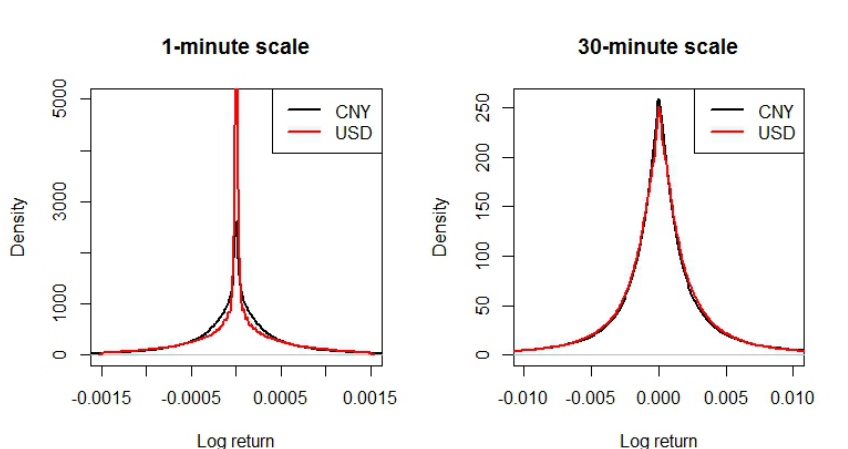
Figure 5. Distribution of high-frequency returns computed from closing prices on a minute scale and a half-an-hour scale for Bitcoin prices in CNY (black) and USD (red). A non-Gaussian shape is observed in all